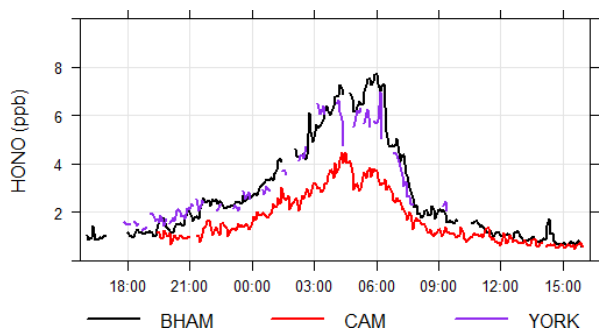
Figure 5. Time series for the period when the YORK instrument measured at ground level during the summer